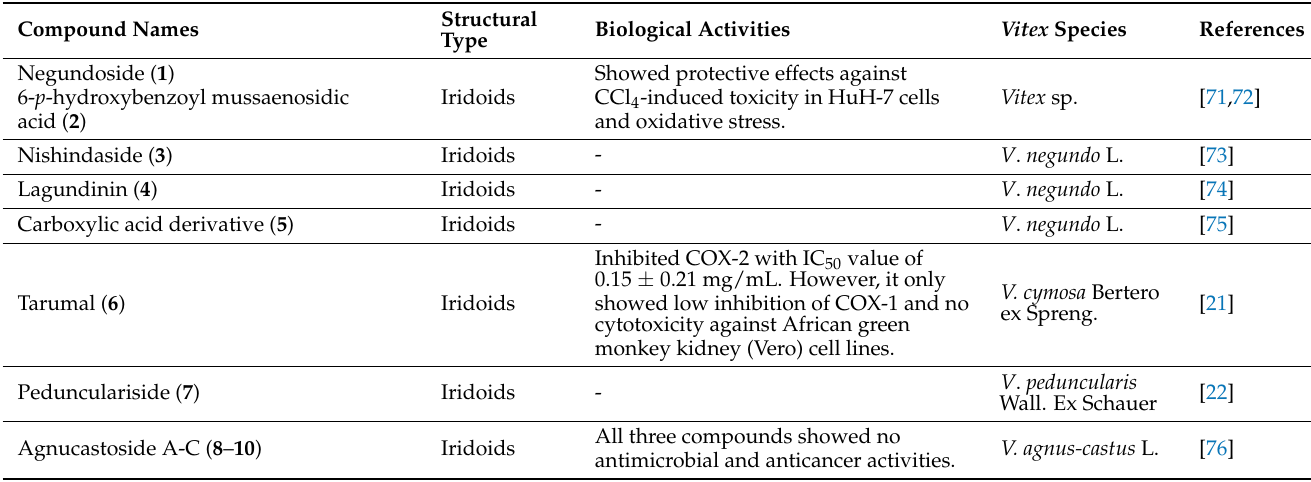
Table 2. Summary of different compounds isolated from various Vitex species and their biological